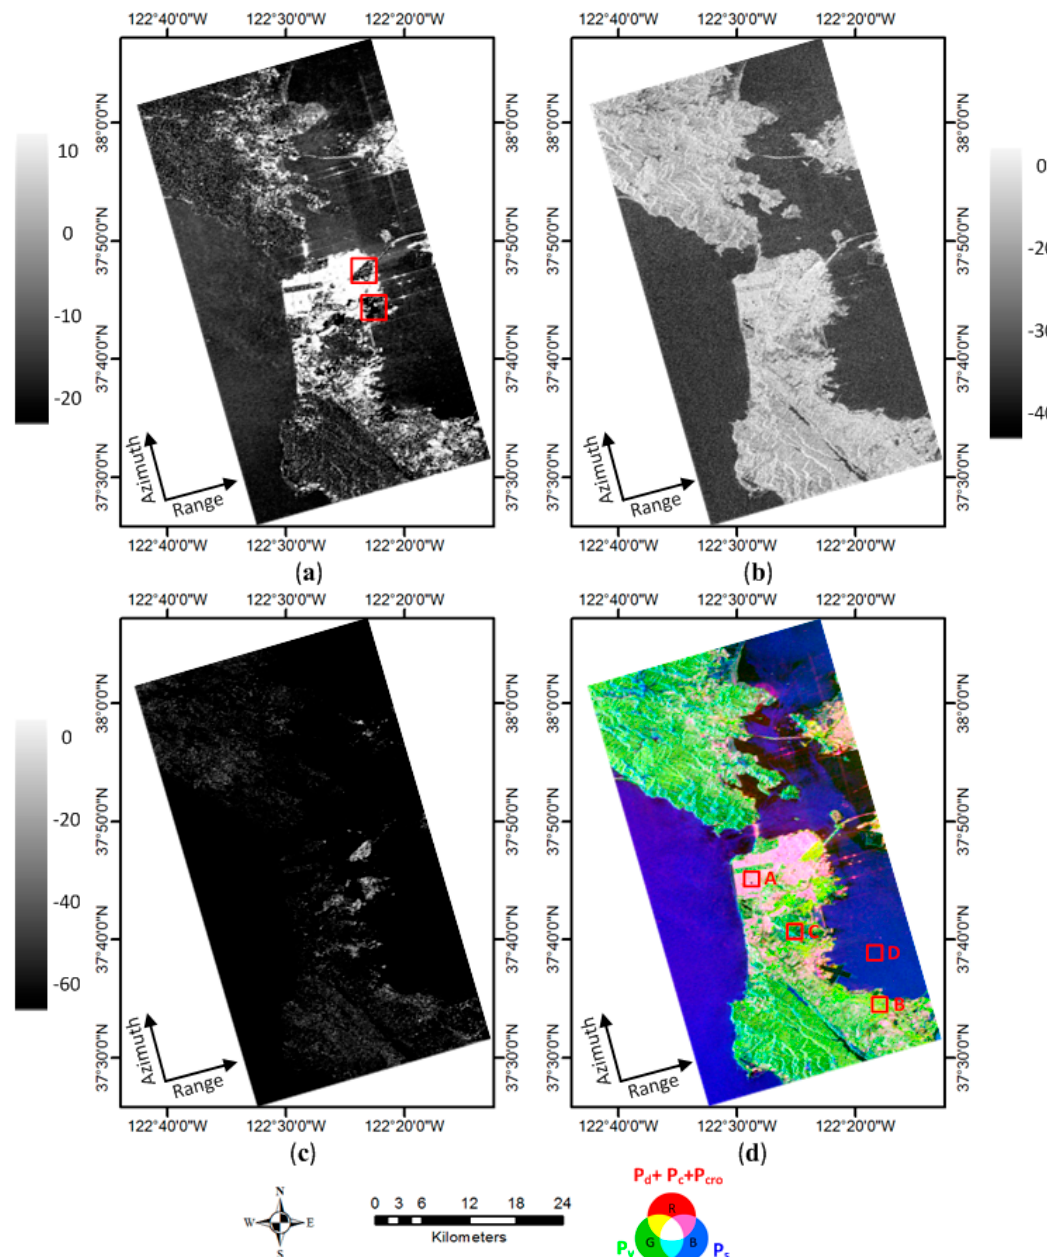
Figure 4. Results of our multiple-component decomposition method: ( a ) double-bounce scattering power; ( b ) helix scattering power; ( c ) cross scattering power; and ( d ) color-coded decomposition result. All of the scattering powers are recalculated in decibels by 10 × log (cid:2869)(cid:2868) (power) .